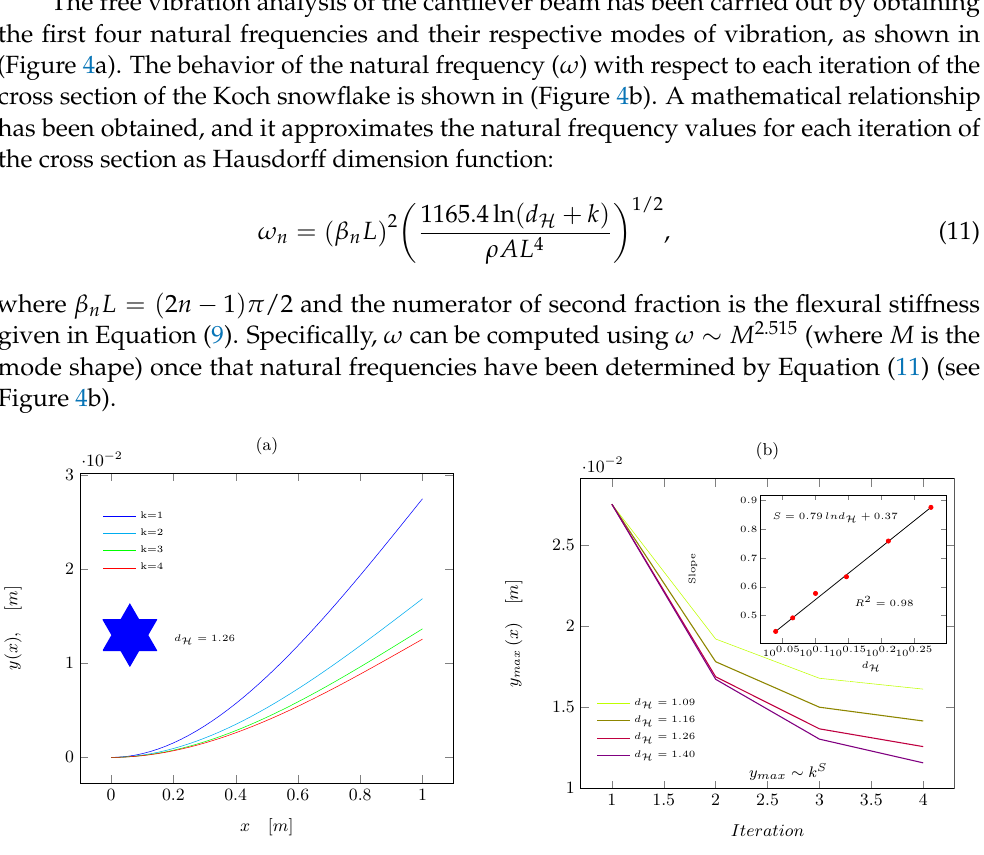
Figure 3. Static response of beams ( a ) displacement for a cross section with d H = 1.26 and ( b ) maxi- mum lateral displacement for several cross sections with different Hausdorff